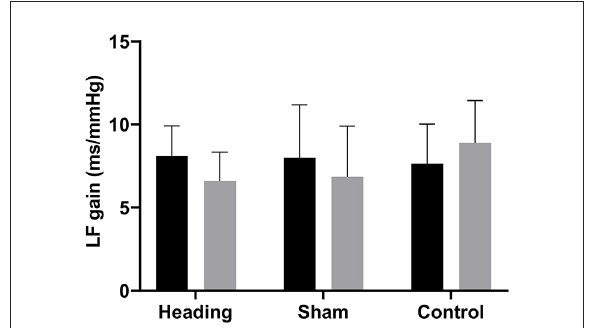
FIGURE5 Cardiac baroreceptor sensitivity comparing before and after exposure to heading, sham, and control conditions across all participants, which is represented by the low frequency (LF) gain metrics. The columns are average values for the group with the standard deviation being represented with the error bars ( p- values all >